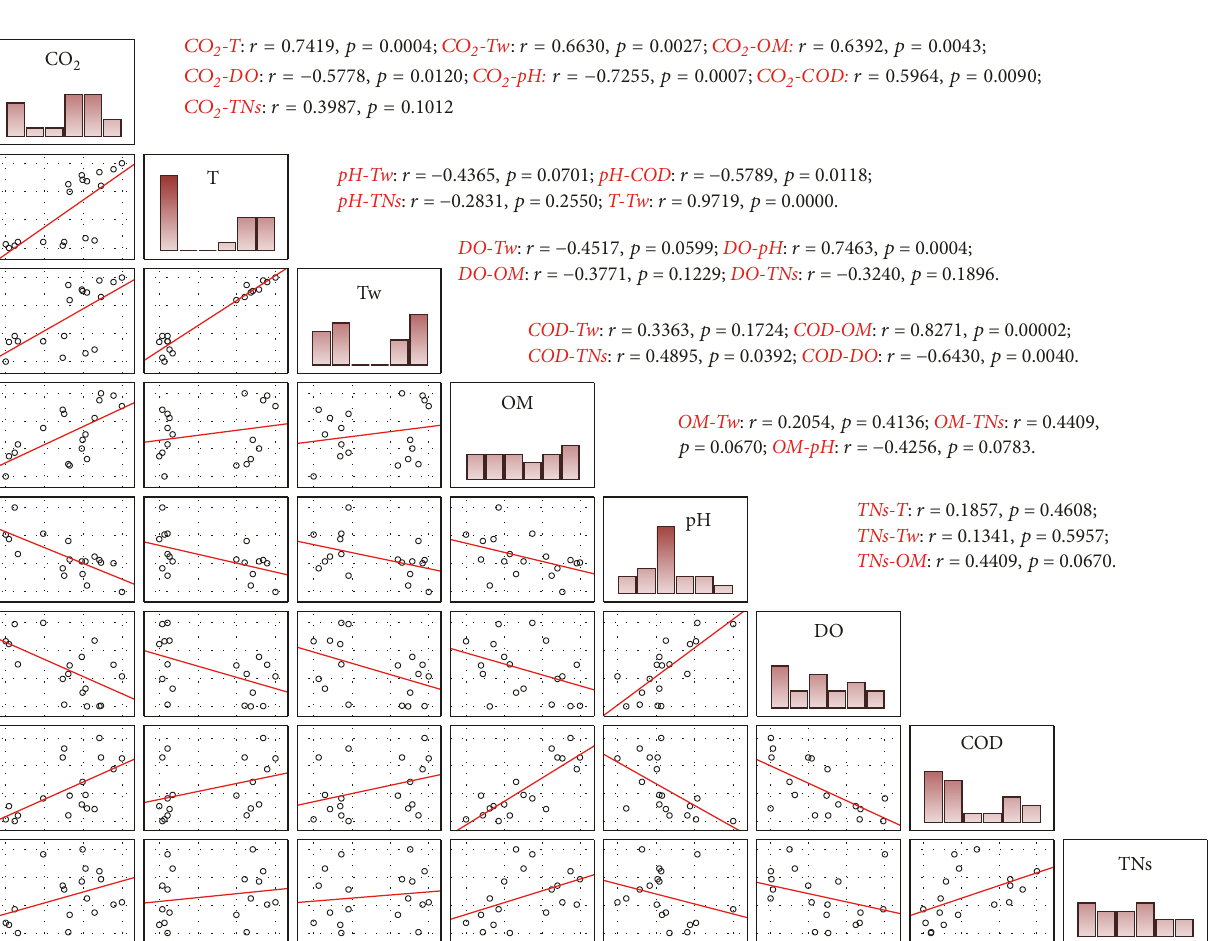
Figure 4: The linear trend between independent variables and lg CO 2